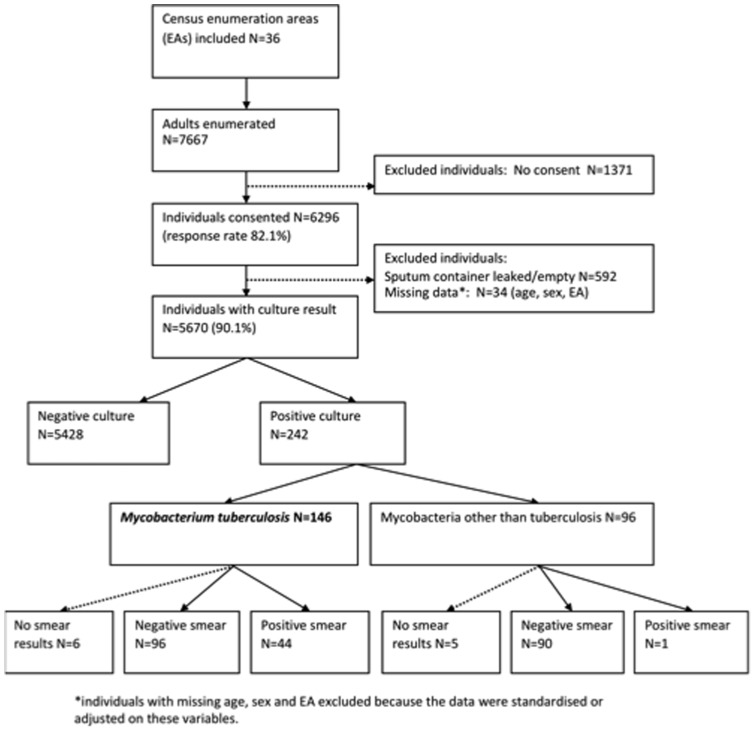
Flow chart of participants included in the survey.